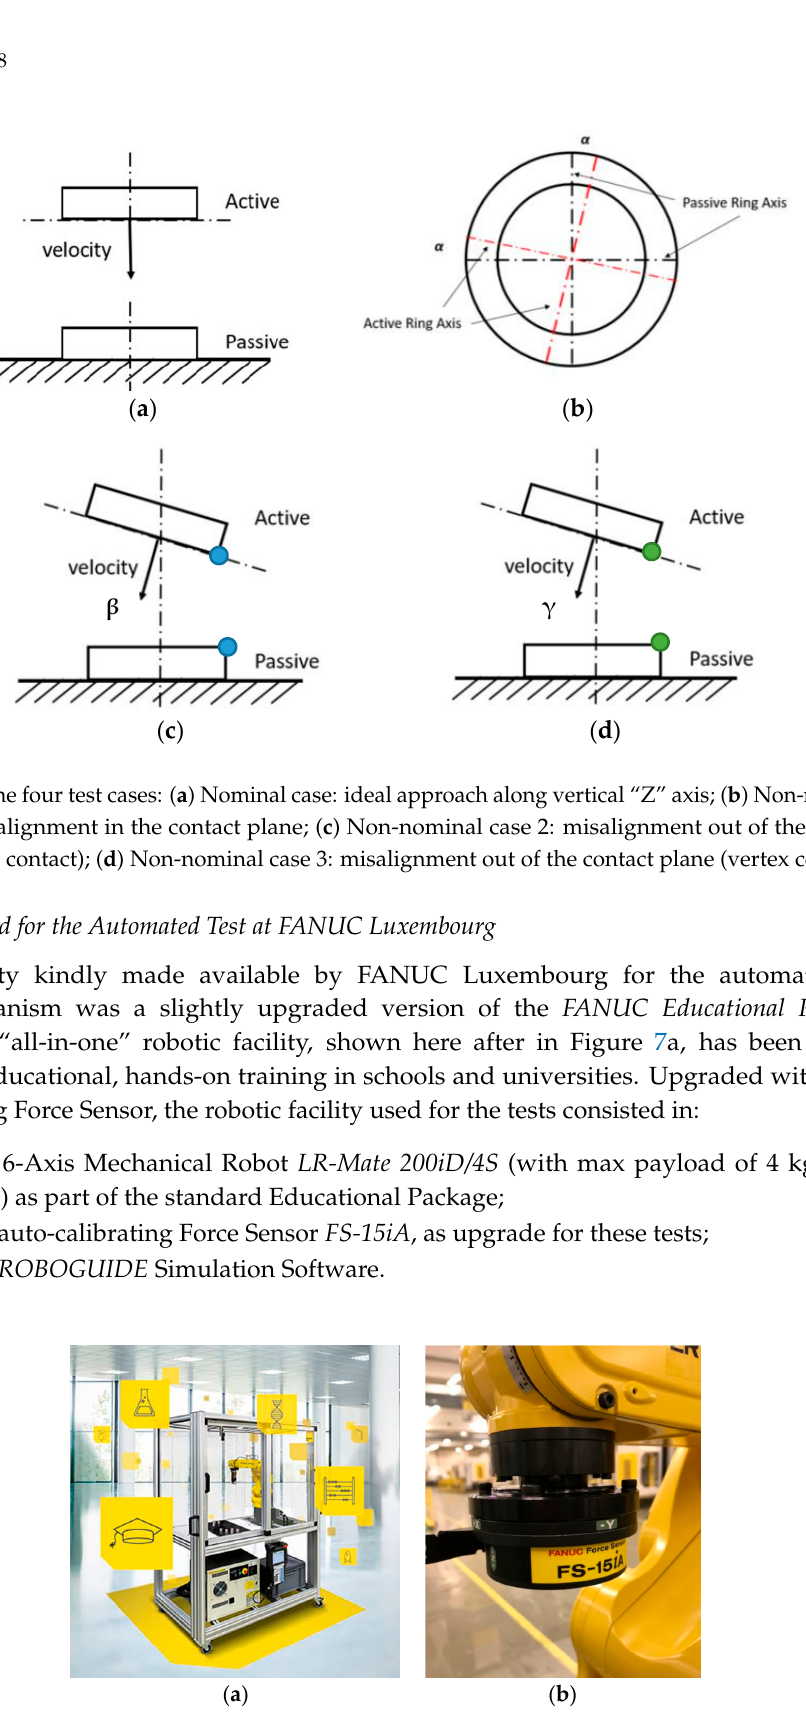
( c ) Figure 5. The three In-Orbit Attach Mechanisms designed for the project ( a ) based on the International Docking System Standard (IDSS) [14]; ( b ) based on the Universal Docking Port (UDP) [16]; and ( c ) based on the concept proposed for the ESA Mars Sample Return (MSR) mission [20]. 2.3. Test Cases for the Automated Test at FANUC Luxembourg As part of the In-Orbit Attach Mechanisms development, a verification plan has been prepared including a first automated (i.e., robotized) test of the connection/matching between the two parts of the 3rd (Plastic-printed) Mechanism. The verification plan intends to replicate the same automated test on the other two (metal-printed) mechanisms as soon as they are produced and made available for such test. Considering a fixed “Passive” part and the other mobile “Active” part approaching at 3 cm/s similarly to the Soyuz when close (<10 m) to the International Space Station (ISS) [21], four test cases have been identified (see Figure 6):  Nominal case : ideal approach along the docking (i.e., “Z”) axis; 